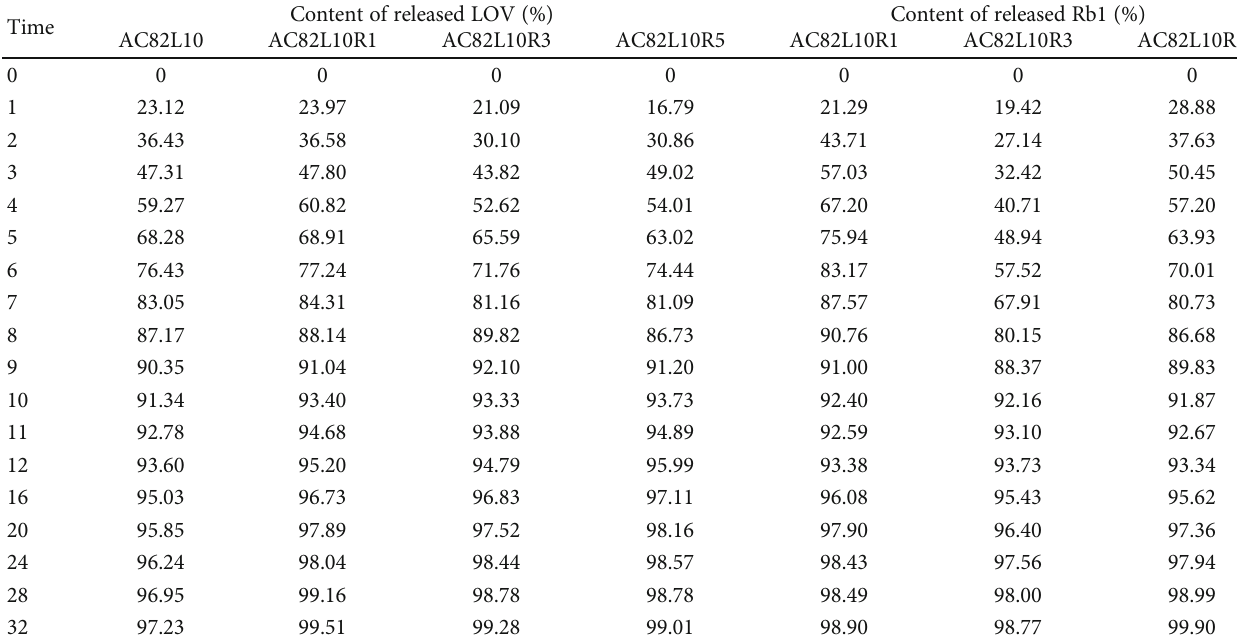
Table 5: The content of LOV and Rb1 released from AC82L10R x composite fi lms in pH 6.8